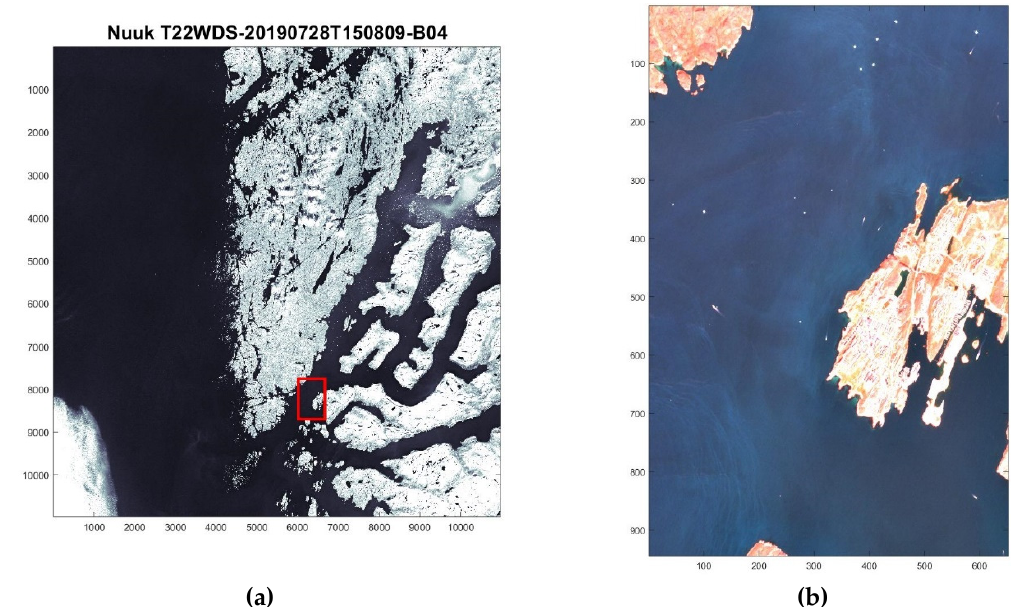
Figure 2. ( a ) ESA Copernicus SciHub Sentinel-2 tile image around Nuuk, the capital of Greenland. The red box shows the inset on the right ( b ), and the RGB image shows icebergs and ships with wakes around Nuuk.